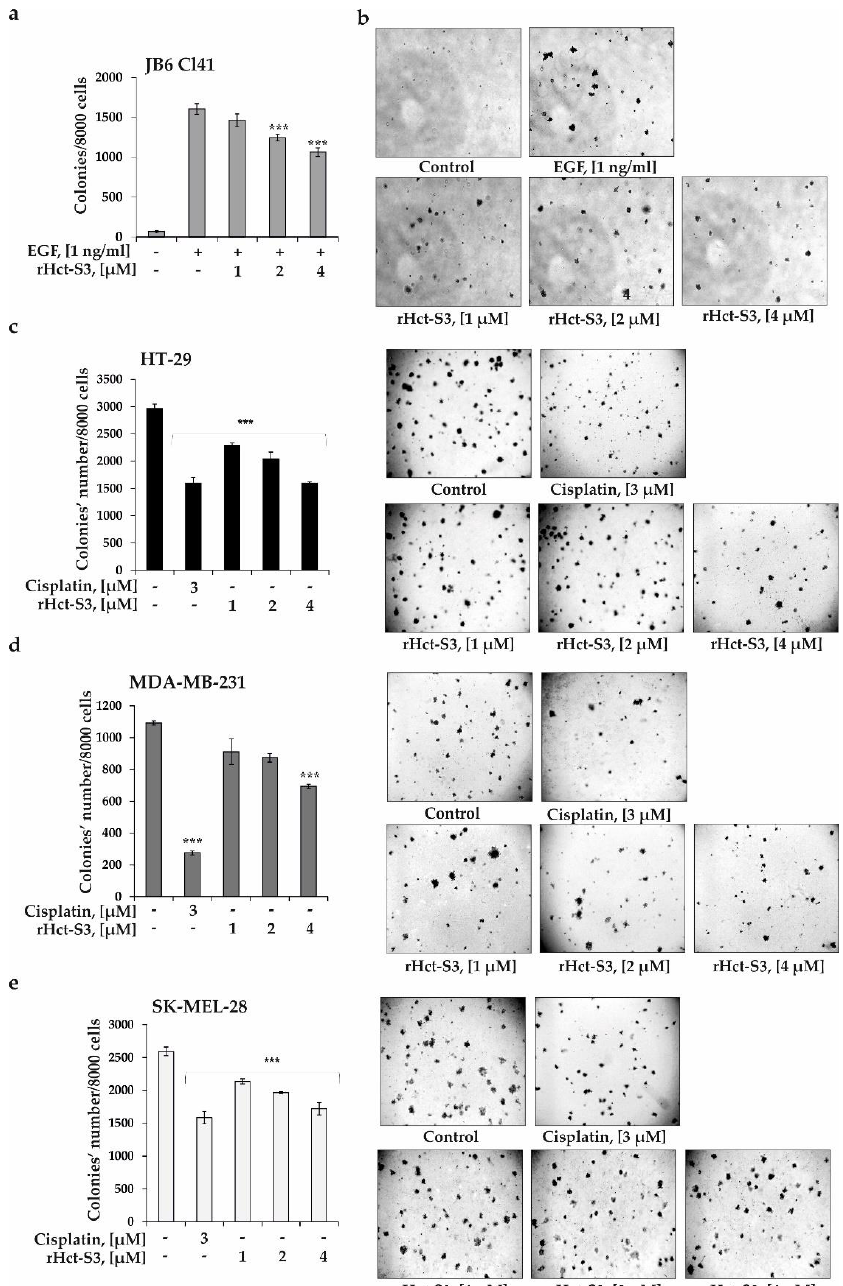
Figure 3. E ff ect of rHct-S3 on EGF-induced neoplastic cells transformation of JB6 Cl41 cells and colony formation of human colorectal carcinoma HT-29, breast cancer MDA-MB-231, and melanoma SK-MEL-28 cell lines. ( a , b ) JB6 Cl41 cells (2.4 × 10 4 / mL) treated with / without EGF (1 ng / mL) or investigated compound (1, 2, and 4 µ M) in 1 mL of 0.3% Basal medium Eagle (BME) agar containing 10% FBS and overlaid with 3.5 mL of 0.5% BME’s agar containing 10% FBS. The culture was maintained at 37 ◦ C in a 5% CO 2 atmosphere for 2 weeks. ( c ) HT-29, ( d ) MDA-MB-231, ( e ) SK-MEL-28 cells (2.4 × 10 4 / mL) treated with / without investigated compound (1, 2, and 4 µ M) or cisplatin at 3 µ M (positive control) and subjected into a soft agar. The culture was maintained at 37 ◦ C in a 5% CO 2 atmosphere for 2 weeks. The colonies were counted under a microscope with the aid of the ImageJ software program ( n = 6 for control and each compound, n —quantity of photos). The magnification of representative photos of colonies is × 10. The asterisks (*** p < 0.001) indicate a significant decrease in colony formation in cells treated with compound compared with the non-treated cells